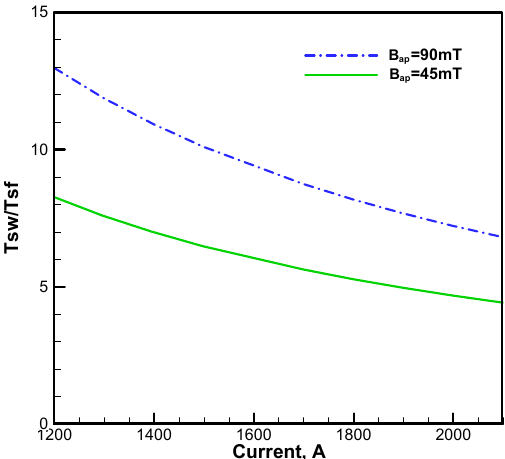
Figure 7. Variations of swirls to self-field thrust ratio with currents.